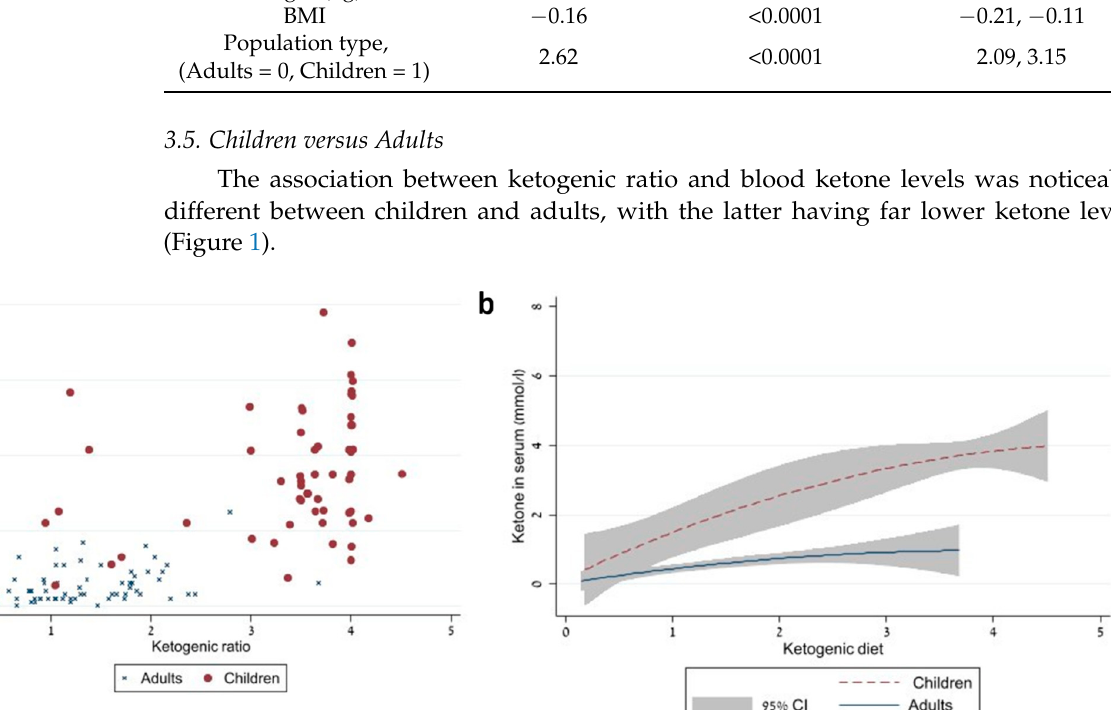
Table 3. Mixed-model multivariate analysis, covariates associated with blood ketone levels.